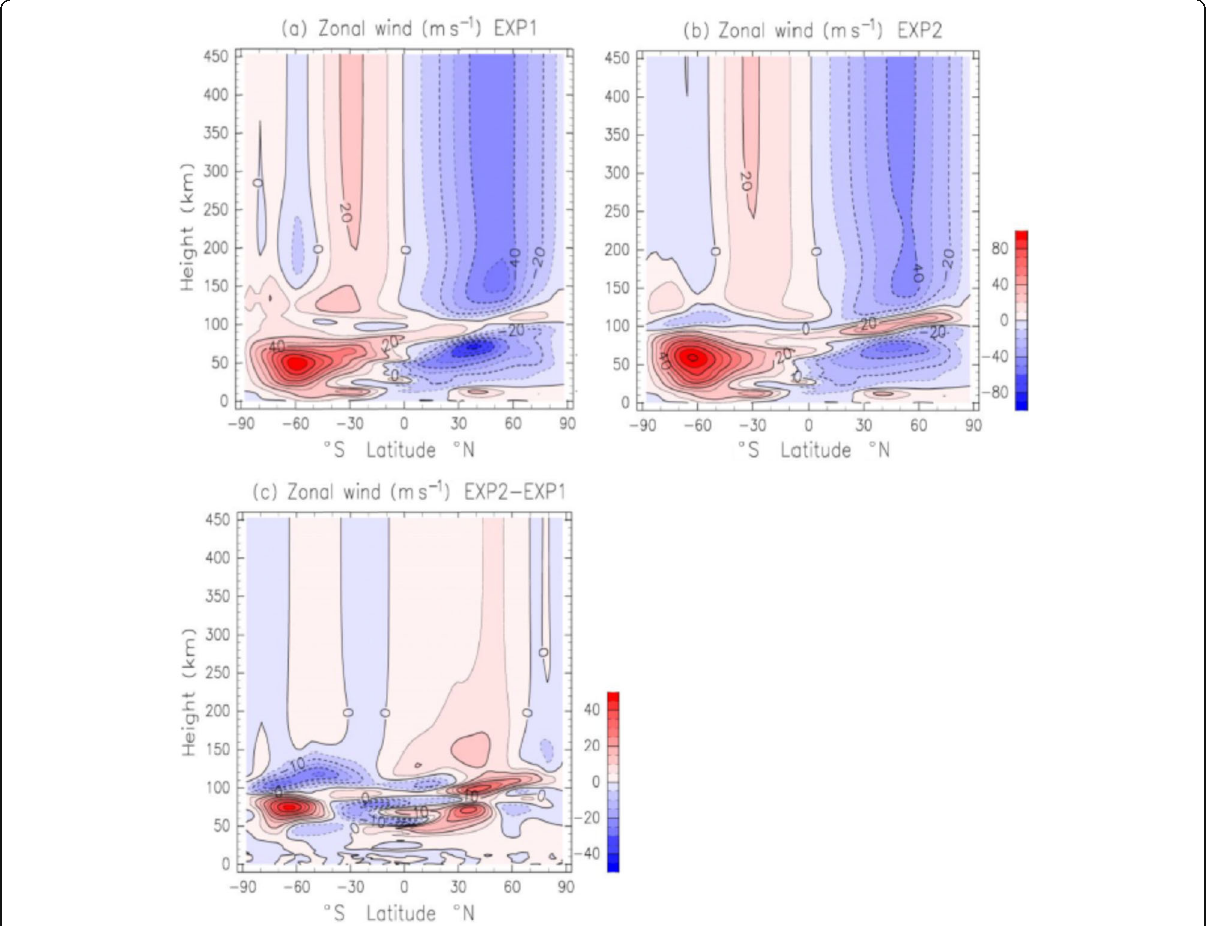
Fig. 15 a Height – latitude section of zonal and diurnal-mean zonal wind obtained by EXP1 (the application of the Lindzen ’ s gravity-wave parameterization scheme (only below 100 km height)). Data are averaged from 1 to 30 June. Contour intervals of black lines are 10 ms -1 . Negative and positive values are eastward and westward winds, respectively. b As in a , except for the application of the Yi ğ it et al. (2008) ’ s parameterization scheme in the whole atmosphere (EXP2). c Difference of the zonal wind between EXP1 and EXP2 (EXP2 – EXP1). Contour intervals are 5 ms -1 (taken from Miyoshi and Yigit